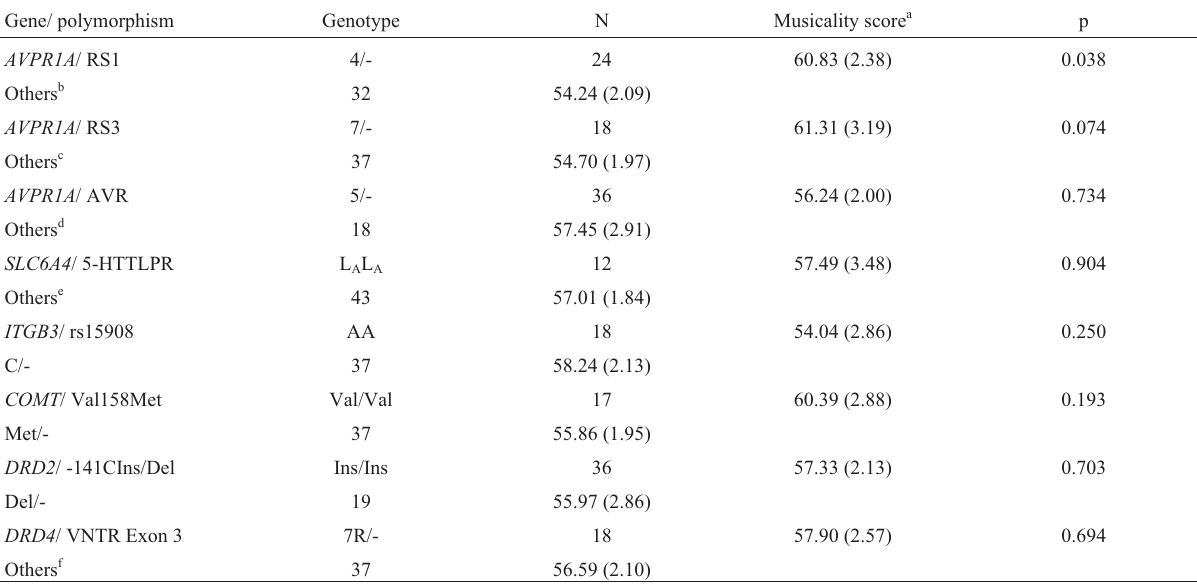
Table 2 - Results of analyses for association between musicality scores and polymorphisms. Gene/